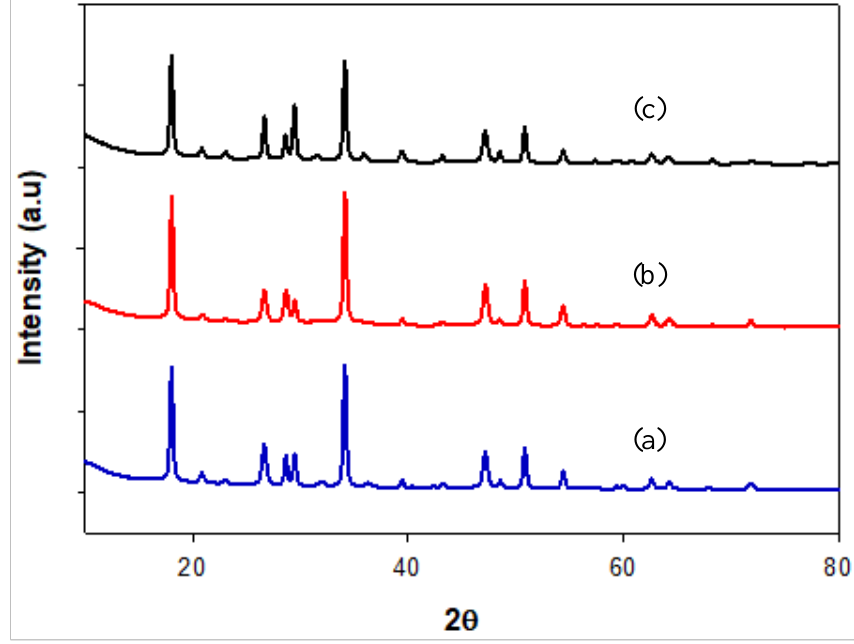
Figure 2. XRD di ff ractograms of CaO / PMFA calcinated at 900 ◦ C at various calcination times of ( a ) 2, Figure 2. XRD diffractograms of CaO/PMFA calcinated at 900 °C at various calcination times of ( a ) 2, ( b ) 2.5, and ( c ) 3 ( b ) 2.5, and ( c ) 3 h.